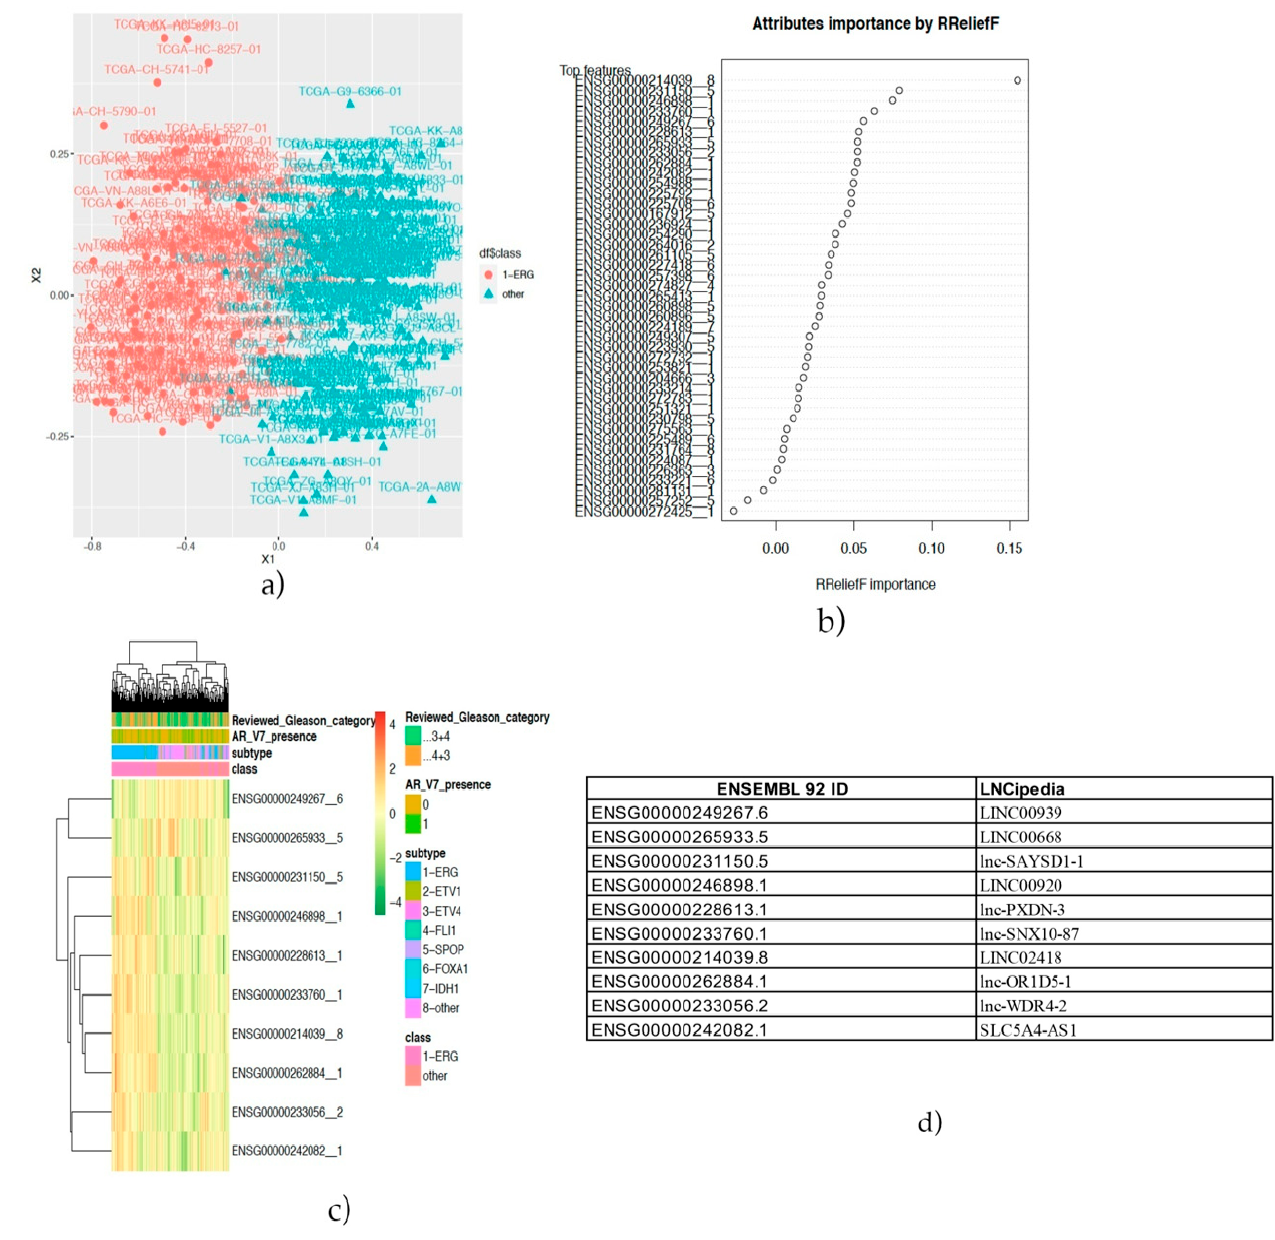
Figure 2. ( a ) Multidimensional scaling plot that shows the effects of normalization and data adjustment. ( b ) Feature importance plot showing the best performing long non-coding RNAs (lncRNAs). ( c ) Cluster gram of the best top 10 lncRNAs discriminating ERG/not-ERG subtypes, and ( d ) an Ensembl ID/LNCPipedia ID conversion table.